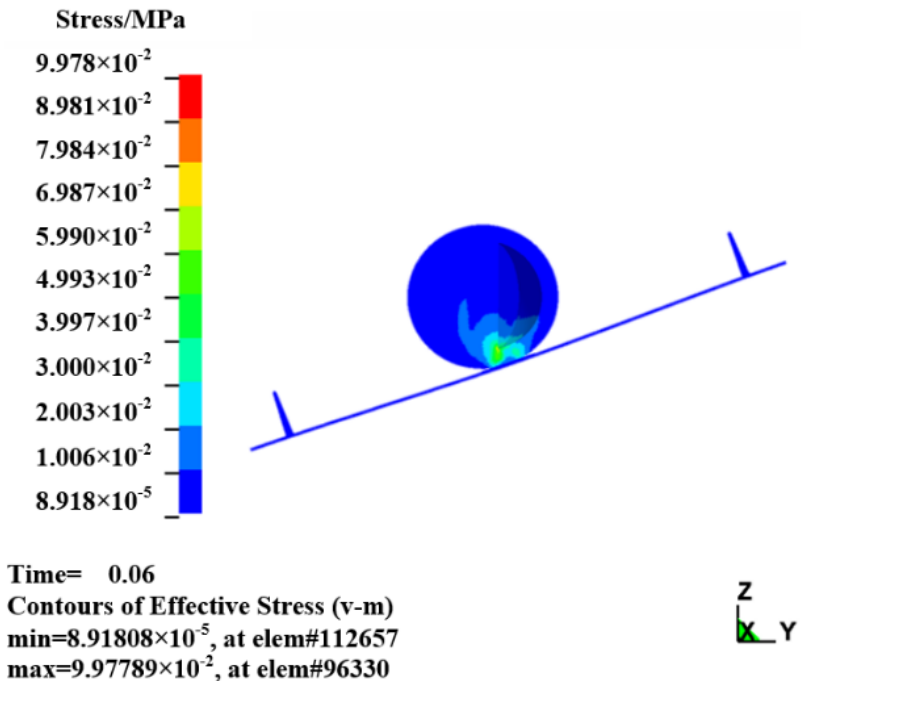
Figure 10. Simulation results of tomato drop in condition 2.